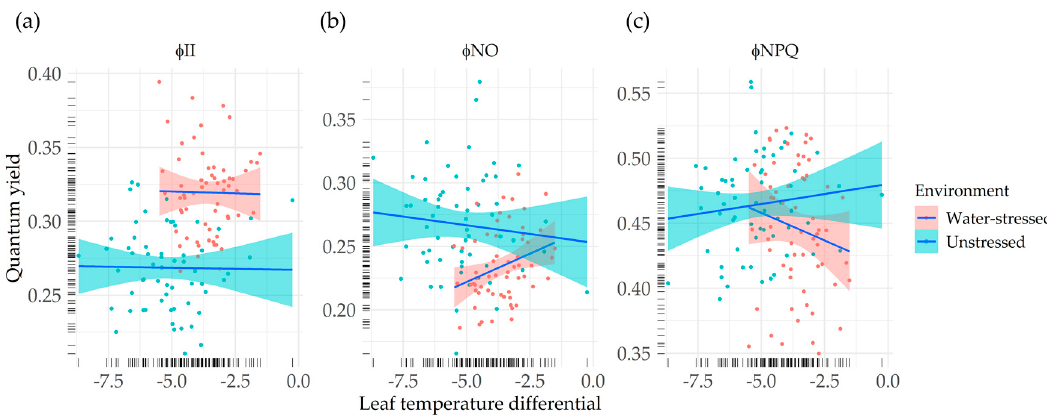
Figure 4. Correlation between quantum yields and leaf temperature differential under environments . ( a ) E ff ective quantum yield of PSII photochemistry vs. LTD; ( b ) quantum yield of non-regulated non-photochemical energy loss in PSII vs. LTD; ( c ) quantum yield of regulated non-photochemical energy loss in PSII vs. LTD. In each panel, genotypic means (dots) and regression lines (lines) are represented for water-stressed (red) and unstressed conditions (blue). Rugs of lines in the axes represent the distribution of the genotypic means.